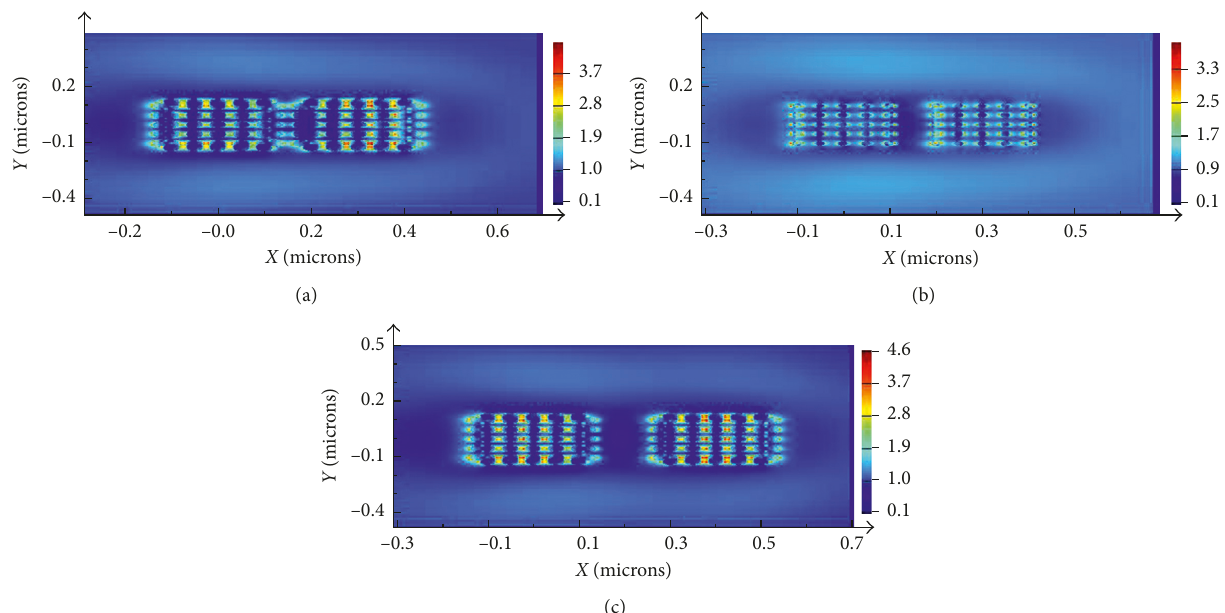
Figure 8: Simulation results of electric field distribution of SERS substrates we have made. The size of all TiO NPs are 50nm. Diameters of Au-NPs and gap between TiO x -NRs are different: (a) 40nm and 100nm, (b) 20nm and 100nm, and (c) 40nm and